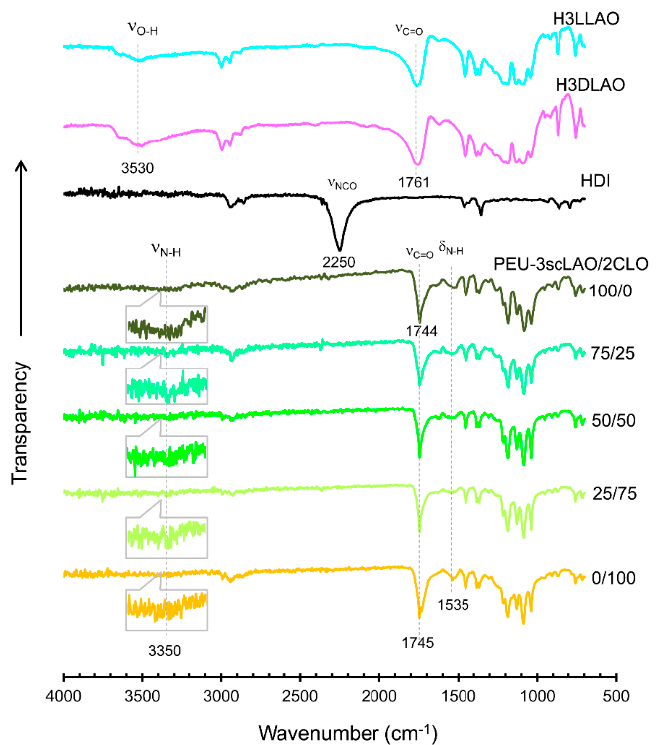
Figure 2. FT-IR spectra of H3LLAO, H3DLAO, PEU-3scLAO/2CLOs (100/0, 75/25, 50/50, 25/75 and 0/100) and HDI. For PEU-3scLAO/2CLOs, longitudinally enlarged spectra at the wavelength region from 3100 to 3600 cm − 1 are also shown in the figure.